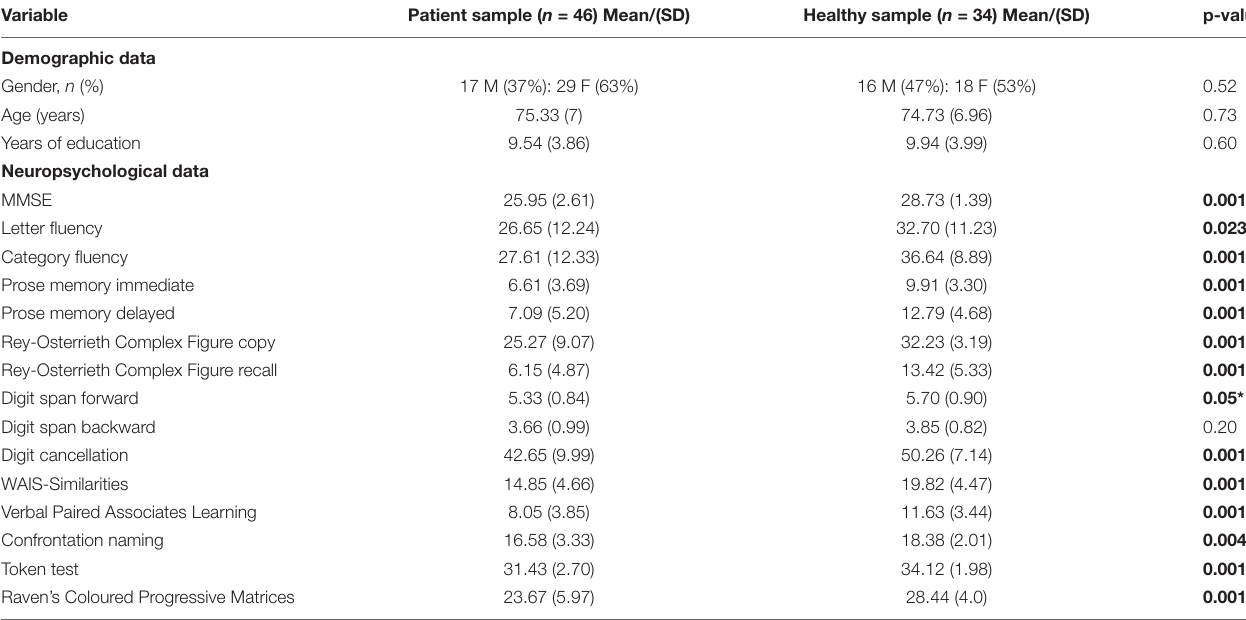
TABLE 1 | Demographic characteristics and cognitive profile of the patient sample ( n = 46) and healthy sample. Variable